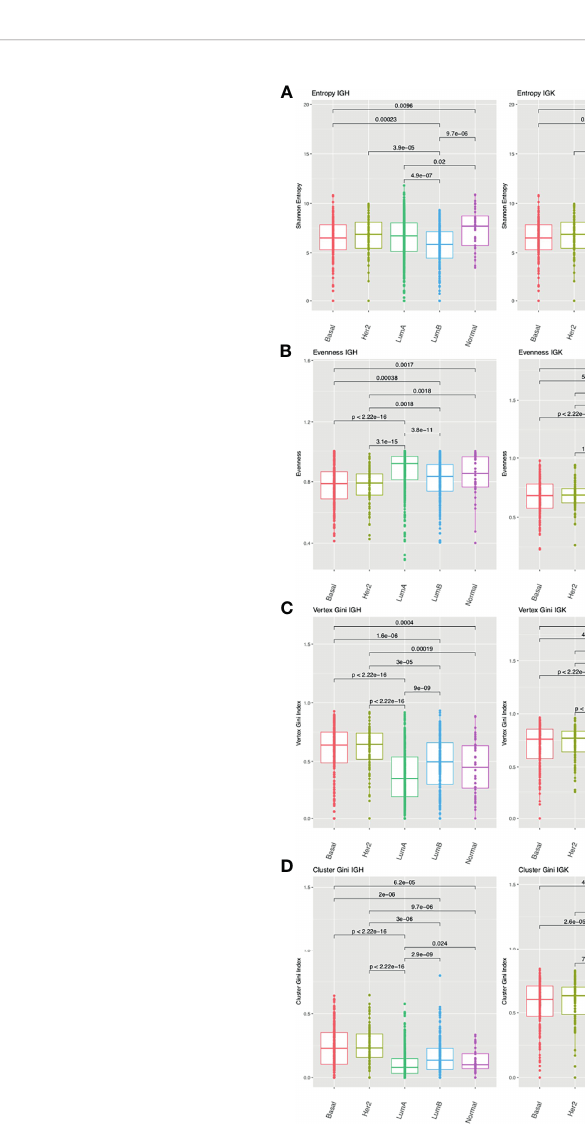
FIGURE 4 | Differences in B cell repertoire features across breast cancer subtypes. (A) Boxplots depict the Shannon entropy index in each BRCA subtype for IGH, IGK, and IGL. Brackets indicate signi fi cant comparisons using the Wilcoxon rank-sum test and p-values are placed above each bracket. (B) Boxplots depict Pielou ’ s evenness index in each BRCA subtype. (C) Boxplots depict the vertex Gini index in each BRCA subtype. (D) Boxplots depict the cluster Gini index in each BRCA